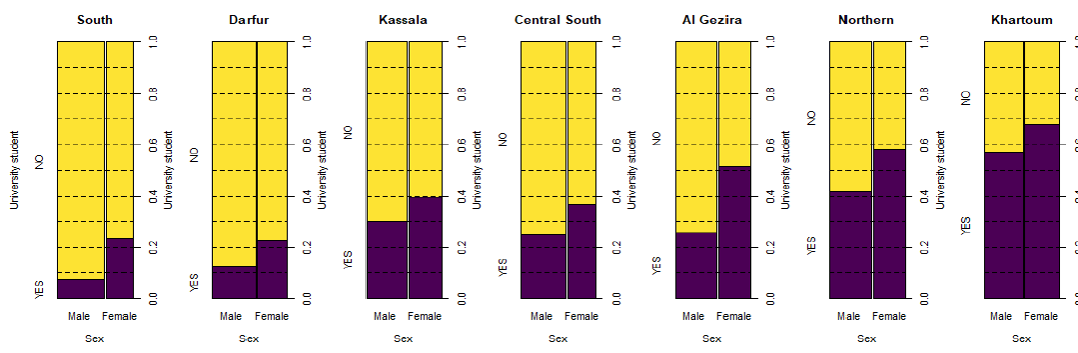
Figure 4. University attendance rates by sex of 19–21-year-olds, by region.